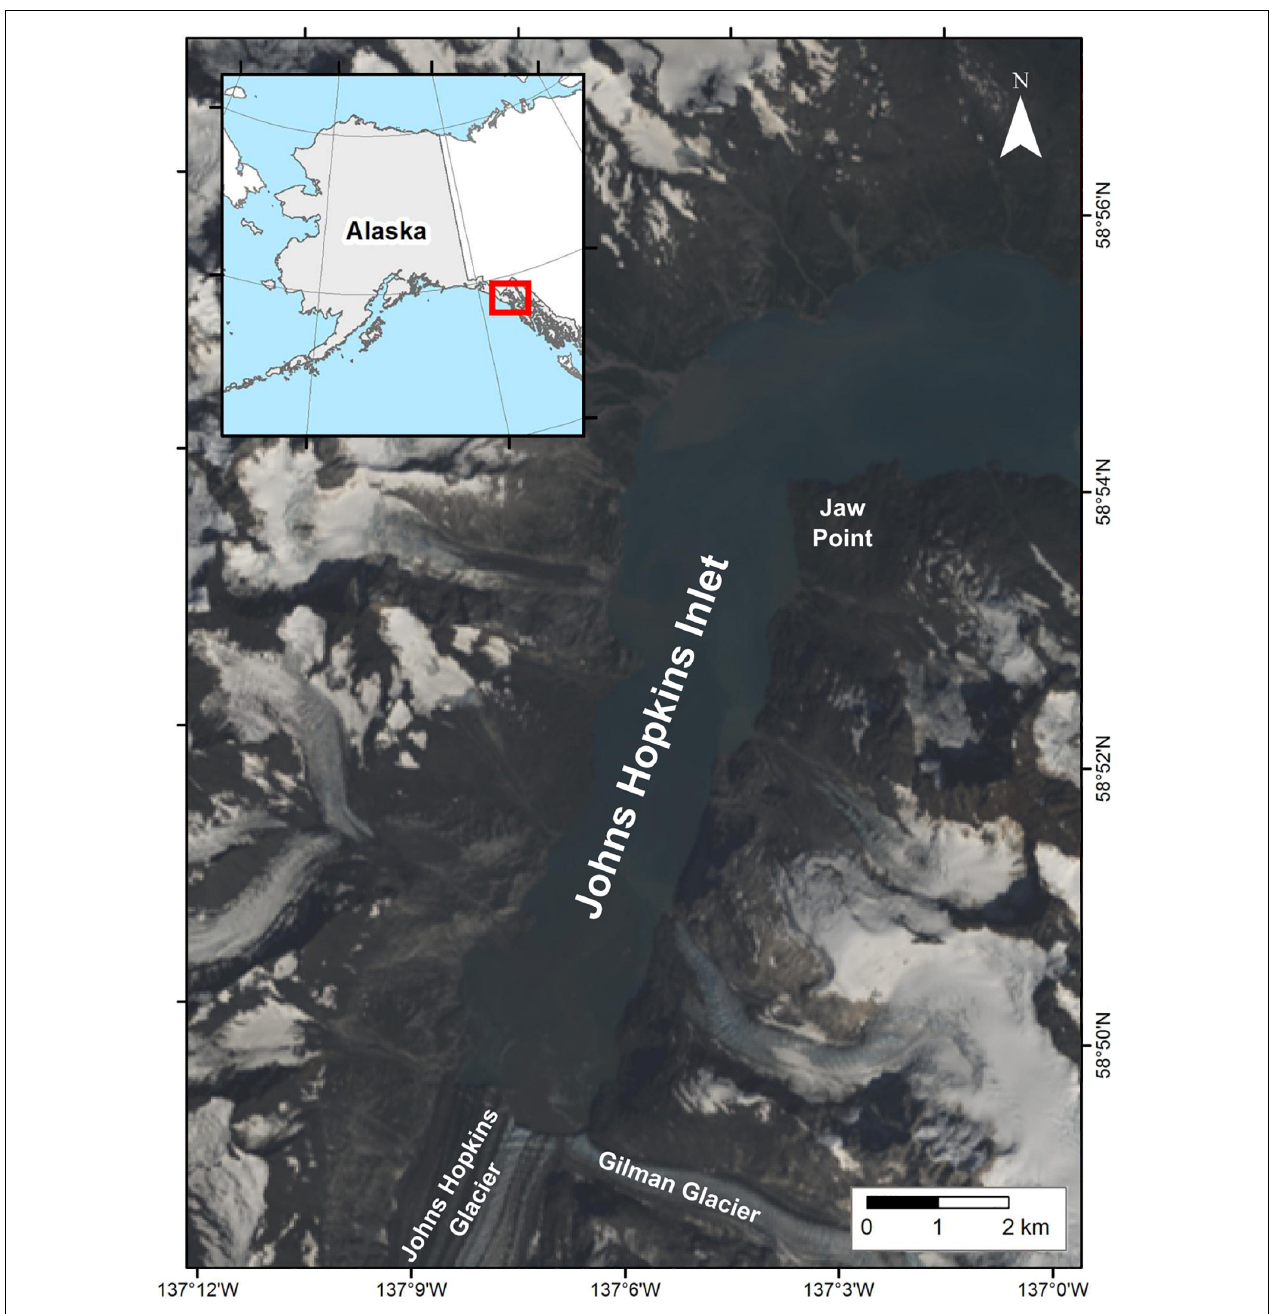
FIGURE 2 | Study area in Johns Hopkins Inlet in Glacier Bay National Park, southeastern Alaska. The natural color image was created from Landsat 8 from August 6, 2013.